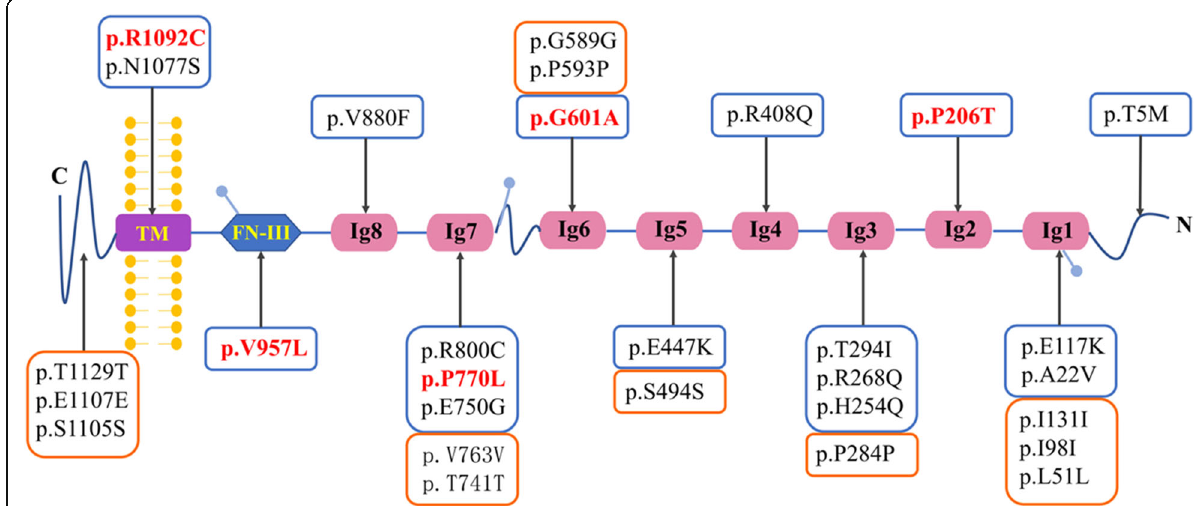
Fig. 1 The variant distributions of NPHS1 in the domains of nephrin protein. Nephrin protein consists of a C-terminal cytoplasmic domain (blue curled line-C), a transmembrane domain (purple rectangle, TM), a fibronectin type III-like module (blue rhombus, FNIII), eight extracellular Ig-like domains (pink oval, Ig 1 – 8) and a signal peptide domain (blue curled line-N). All amino acid changes found in this study were listed. The orange boxes indicate the synonymous mutations for the corresponding protein domains. The blue boxes indicate the missense mutations for the corresponding protein domains. Red bold font indicates the strong susceptibility to